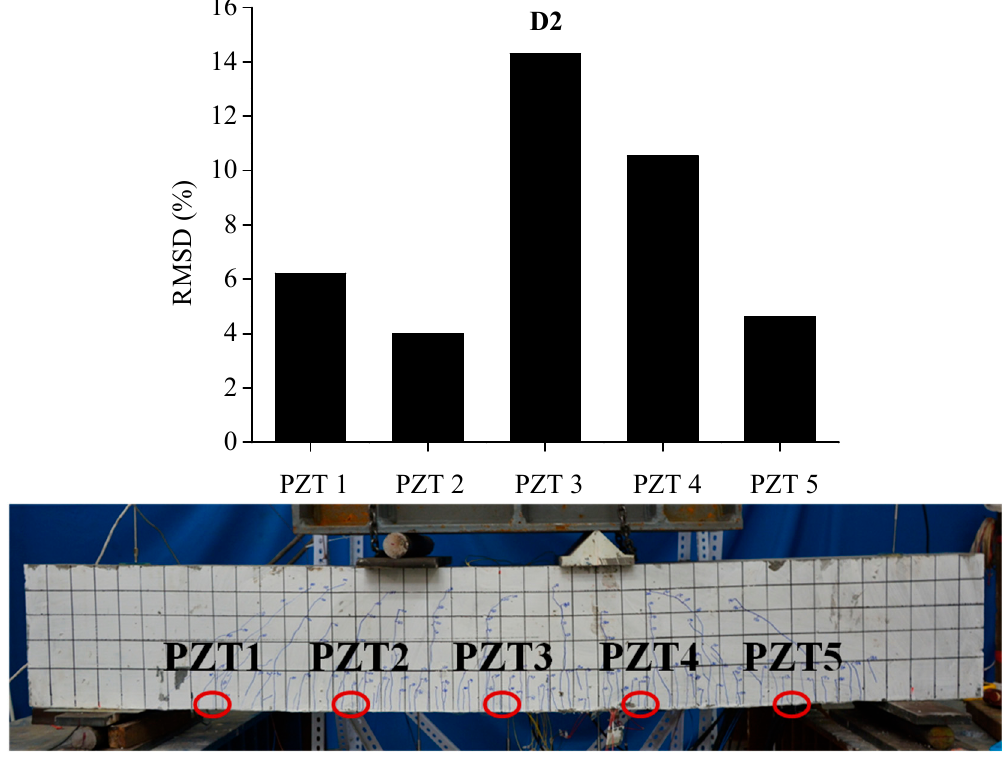
Figure 17. RMSD of each PZT sensor at D2 and the related cracking pattern of BE2.